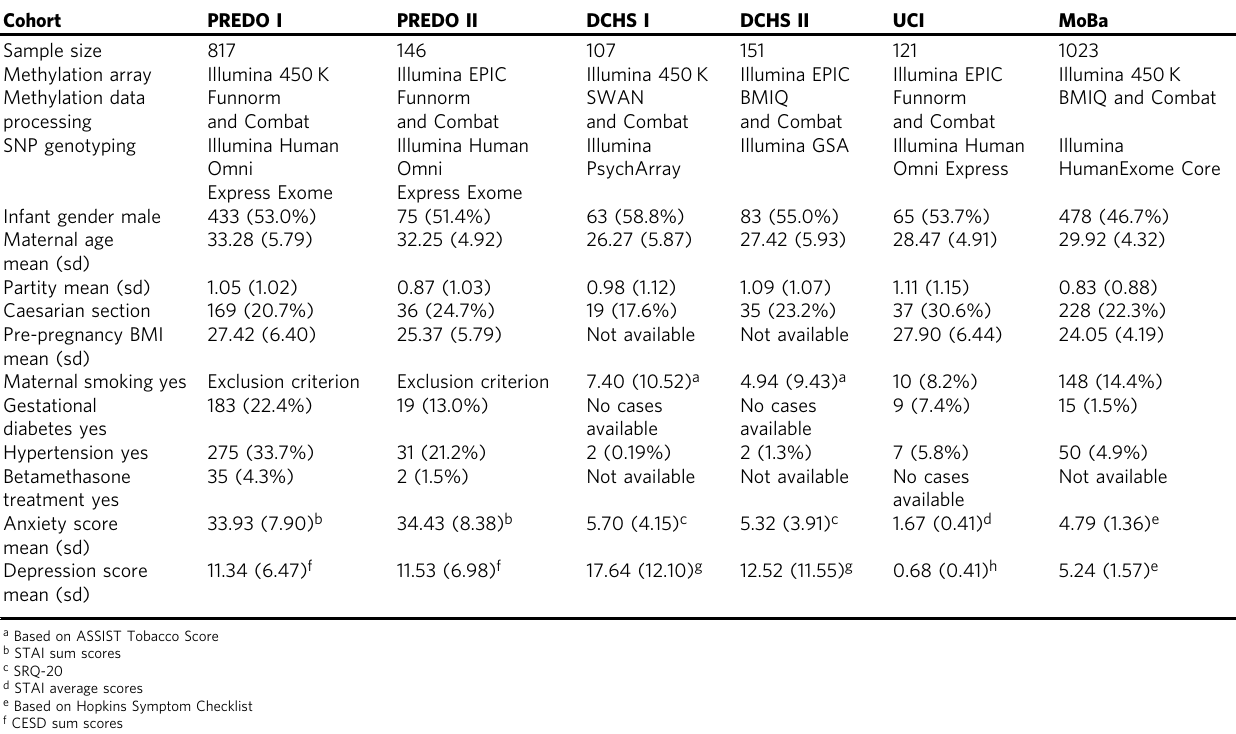
Table 1 Overview of investigated